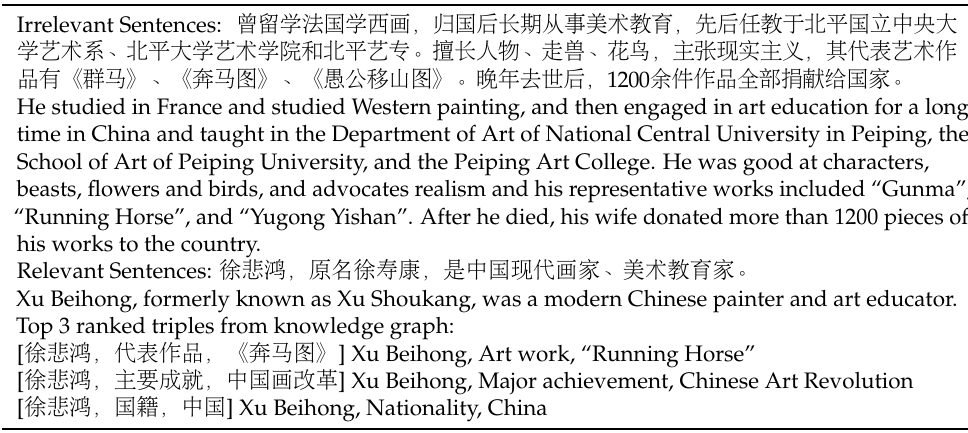
Table 2. An example of compressed passage shown in Table 1 with triples extracted from CN- DBpedia2 linking to 徐 悲 鸿 (Xu Beihong).